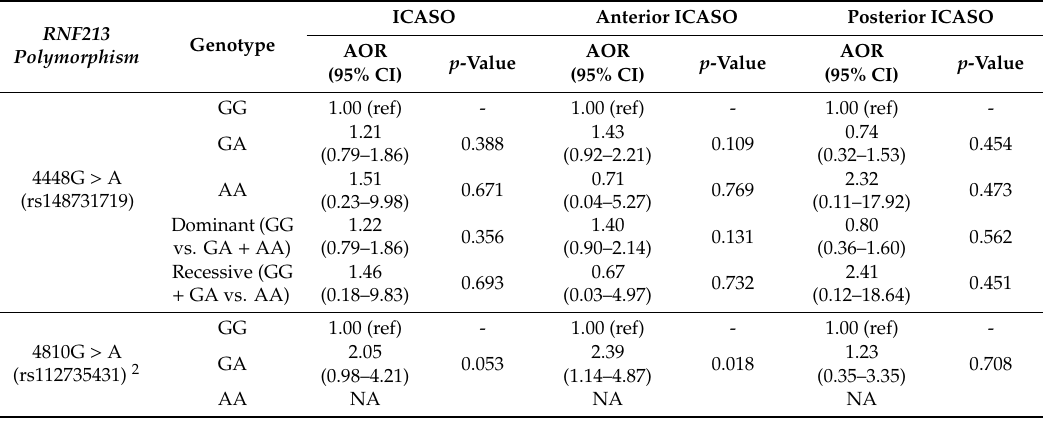
Table 4. Risk of ICASO according to genotype of RNF213